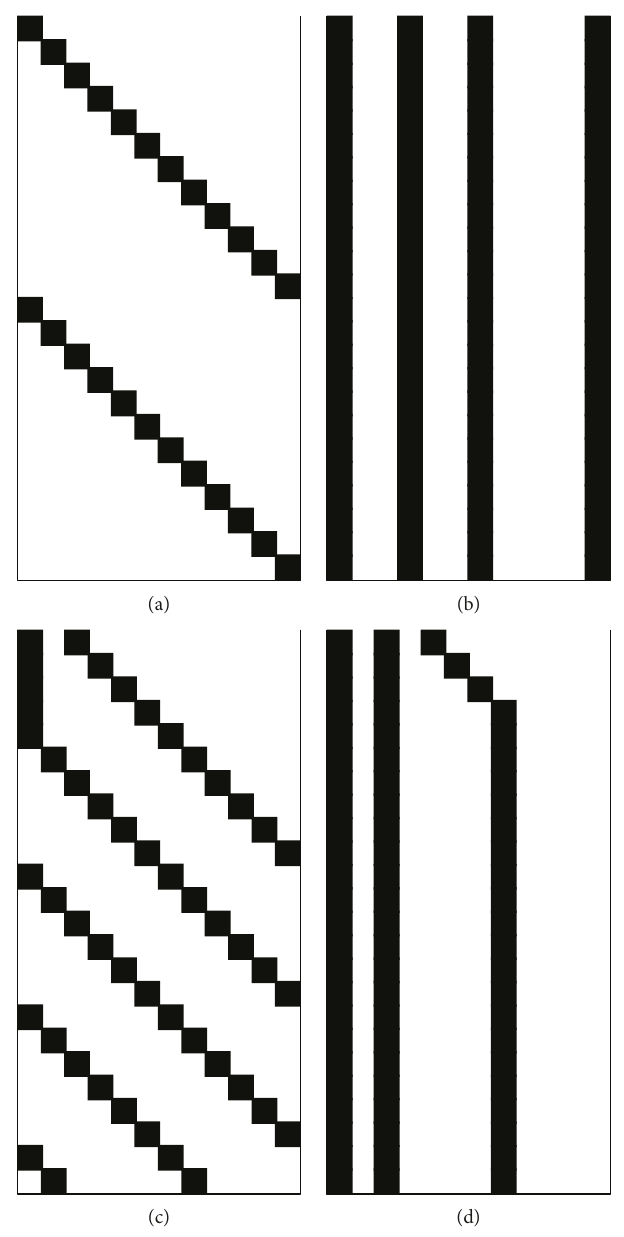
Figure 12: Evolutions of the cellular automaton representing di ff erent initial states of the AMS of Figure